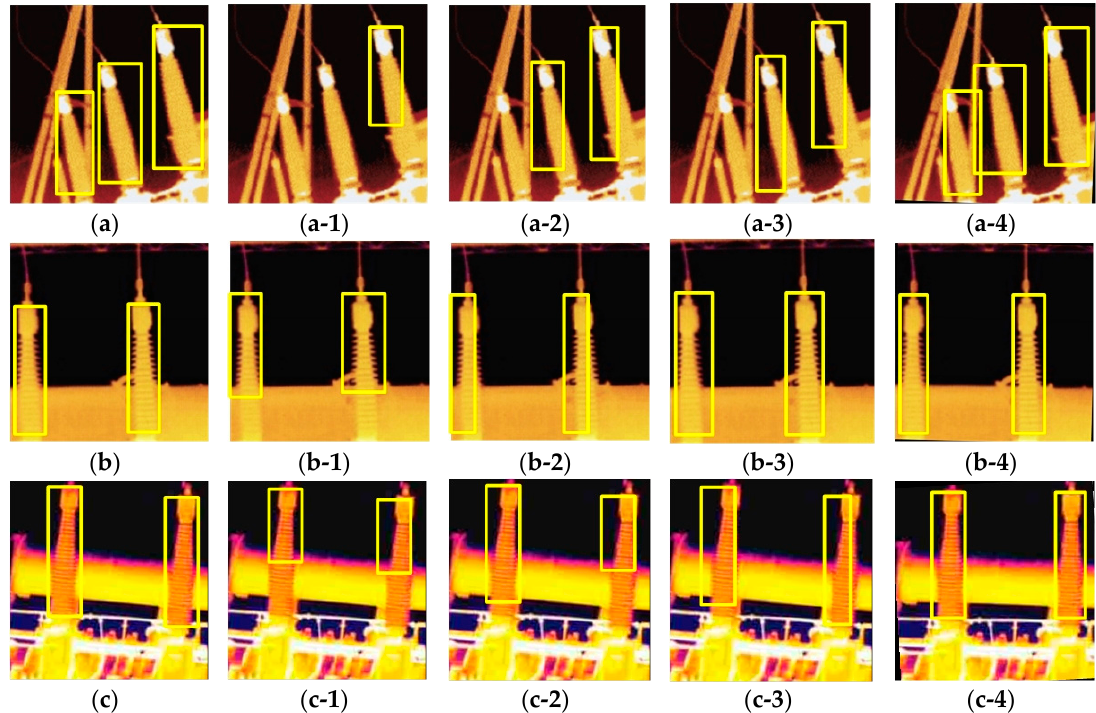
Figure 9. Recognition effect diagram of different algorithms. Object ground truth (OGT) as identification standard is manually marked. ( a-4 ), ( b-4 ), and ( c-4 ) are marked by our algorithm. ( a ) OGT ( a-1 ) YOLO, MIoU = 0.136 ( a-2 ) YOLOv2, MIoU = 0.479 ( a-3 ) YOLOv3, MIoU = 0.593 ( a-4 ) MIoU = 0.724 ( b ) OGT